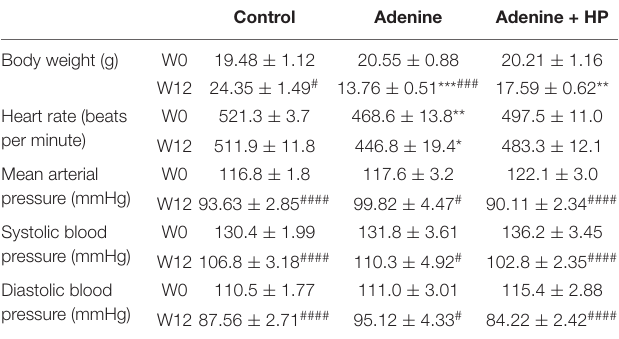
TABLE 1 | Differences in